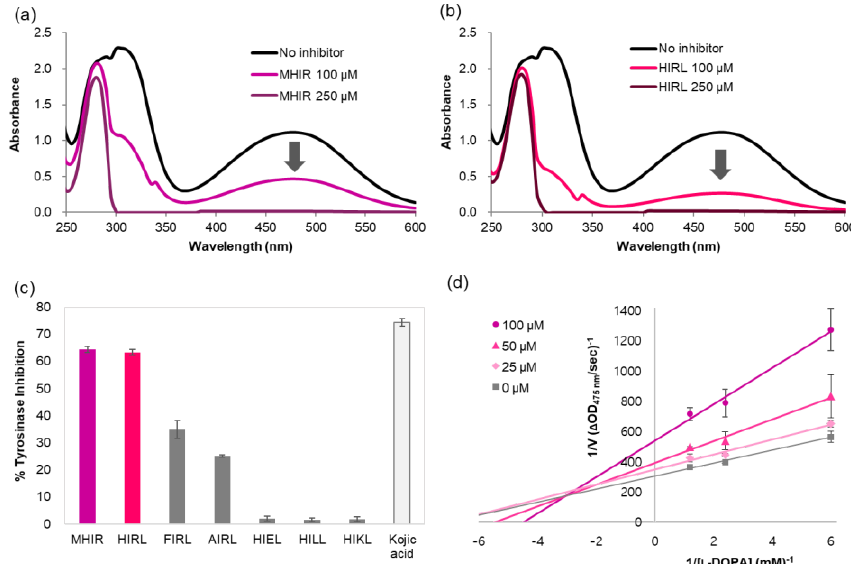
Figure 2. The e ff ects of peptides ( a ) methionine-histidine-isoleucine-arginine amide (MHIR) and ( b ) histidine-isoleucine-arginine-leucine amide (HIRL) on dopachrome formation with L-DOPA and mushroom tyrosinase, ( c ) the mushroom tyrosinase inhibitory activities of MHIR, HIRL derivatives and kojic acid. The percent tyrosinase inhibition was determined after treating 100 µ M of peptides or kojic acid with L-DOPA (2.5 mM)and mushroom tyrosinase (100 µ g / mL, 428 U / mL) and incubating at25 ◦ C for 10min. Eachexperimentwasconductedintriplicateandtheresultswereaveraged. ( d )Lineweaver-Burk plot of tyrosinase inhibition reaction in the presence of MHIR peptide at various